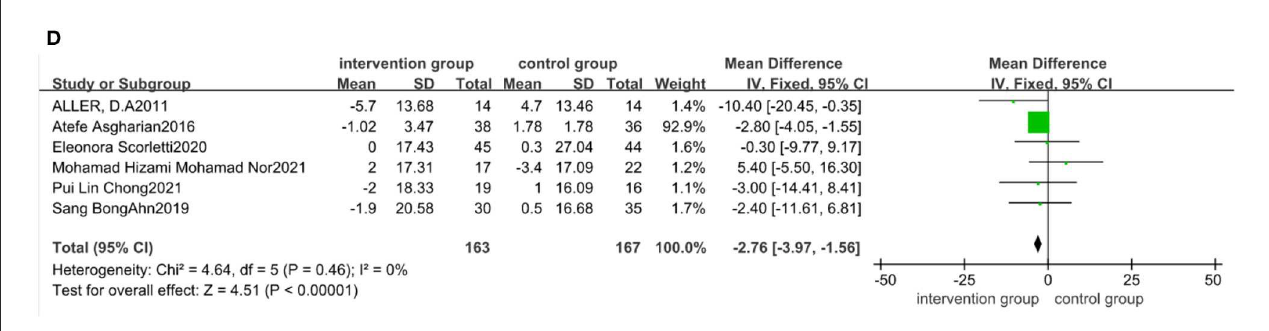
FIGURE5 Forest plot of the effect of functional foods and dietary supplements on liver function (effect of A : antioxidants on ALT; B : probiotic/symbiotic/prebiotic on ALT; C : antioxidants on AST; and D : probiotic/symbiotic/prebiotic on AST).